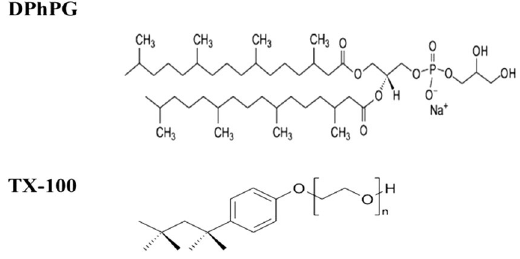
Figure 1. Molecular structure of lipid (DPhPG) and detergent (TX-100). DPhPG contains two hydrocarbon chains of 16 carbons with total lipid molecule length of ~2–3 nm. TX-100 molecule length is ~3.75–4.0